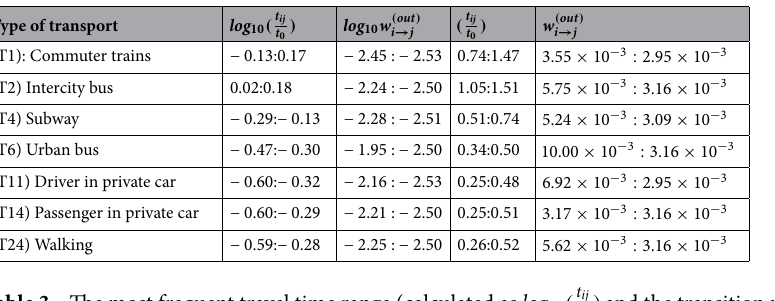
Table 3. The most frequent travel time range (calculated as log 10 ( ( out ) (estimated as log 10 w i → j ): (1) Commuter trains, (2) Intercity bus, (4) Subway, (6) Urban bus, (11) Driver in private car, (14) Passenger in private car, (24)